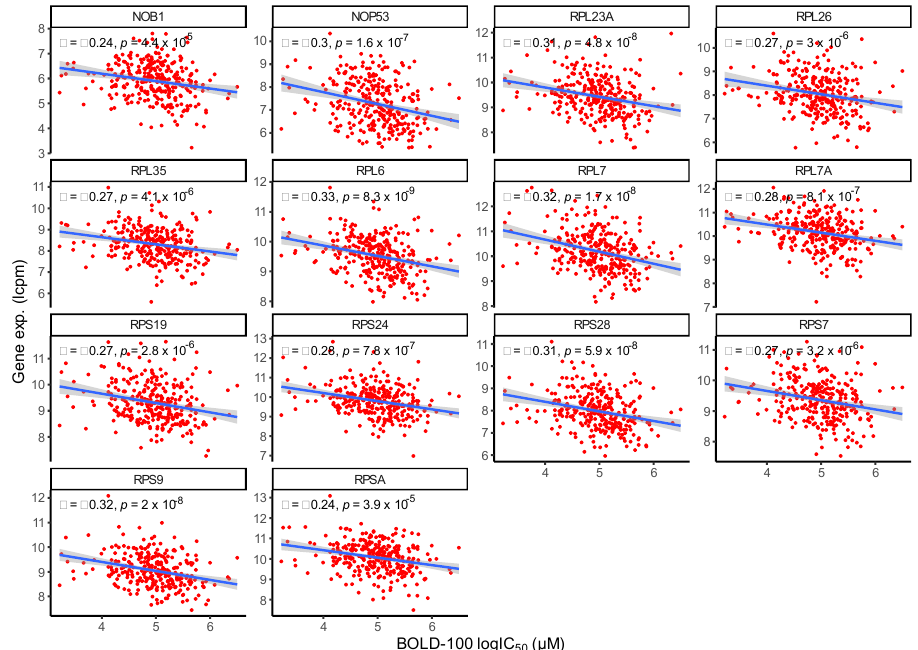
Figure 4. Correlation between genes related to ribosome biogenesis and BOLD-100 sensitivity in the cancer cell line panel. Significant genes within the Gene Ontology (GO) term GO:0042254 — ribosome biogenesis showed consistent negative correlation with BOLD-100 IC 50 from the cell panel. The x-axis denotes the natural log of BOLD-100 IC 50 obtained from the cell panel. The y-axis denotes the normalized gene expression values for each gene in log-counts-per-million (lcpm), as per the data obtained from the Cancer Cell Line Encyclopedia